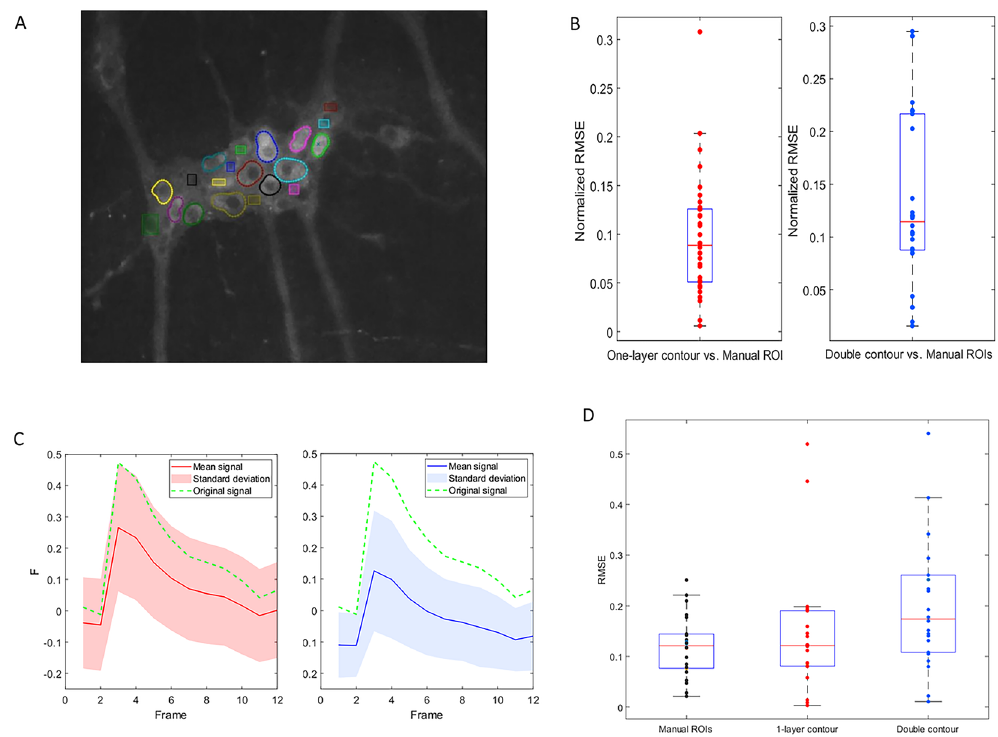
Figure 7. ( A ) Contours of tracked cells and manual rectangular ROIs which are moved based on the contours tracked. ( B ) RMSE of signals extracted using 1 layer (red) and double contour (blue) versus manually selected ROIs by an expert. ( C ) Comparison of the extracted signals (red/blue mean, light red/blue standard deviation) against a ground truth artificial peak (dotted green) using 1-layer contour tracking (left) and double contours (right) based on 22 cells. ( D ) RMSE of signals extracted from 22 cells injected with the artificial peak using manual ROIs (left), 1 layer (center) and double contour (right) versus the ground